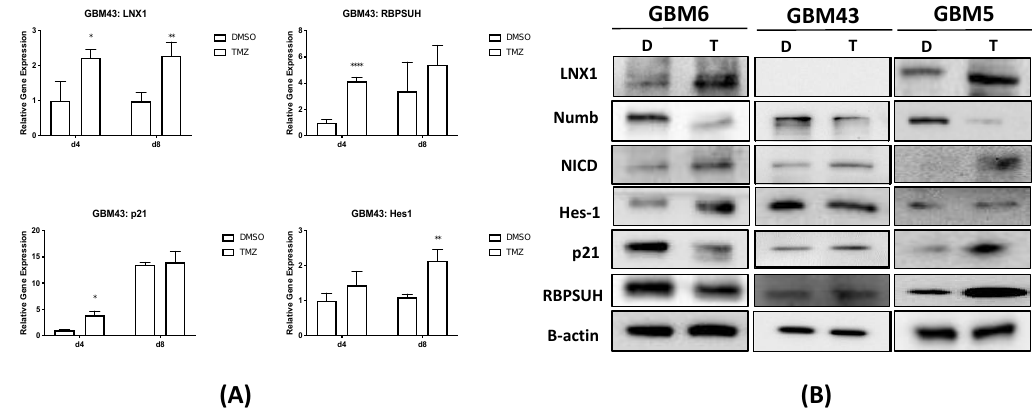
Figure3. TheLNX1-Numb-Notch1axiscontrolsisactivatedafterTMZtherapyinGBM.( A )Examination Figure 3. The LNX1-Numb-Notch1 axis controls is activated after TMZ therapy in GBM. ( A ) of mRNA levels by RT-PCR at 4 and 8 days after therapy with TMZ compared to a DMSO control showed Examination of mRNA levels by RT-PCR at 4 and 8 days after therapy with TMZ compared to a elevations in LNX1, Hes1, p21, and RBPSUH after therapy. ( B ) Western blotting across multiple GBM DMSO control showed elevations in LNX1, Hes1, p21, and RBPSUH after therapy. ( B ) Western patient-derived xenograft (PDX) cell lines and U251 cells showed that LNX1 was upregulated compared blotting across multiple GBM patient-derived xenograft (PDX) cell lines and U251 cells showed that to control after 4 days of TMZ therapy, corresponding with Numb downregulations, and intracellular LNX1 was upregulated compared to control after 4 days of TMZ therapy, corresponding with Numb Notch1 (NICD) upregulations. Following Notch1 upregulation, Notch1 downstream markers p21, downregulations, and intracellular Notch1 (NICD) upregulations. Following Notch1 upregulation, Hes1, and RBPSUH were also elevated. Beta-actin was included as a loading control for all blots Notch1 downstream markers p21, Hes1, and RBPSUH were also elevated. Beta-actin was included as performed. Analysis was performed in Prism 8, using ANOVA to compare row-means to determine a loading control for all blots performed. Analysis was performed in Prism 8, using ANOVA to significance * p < 0.05; ** p < 0.01; **** p < compare row-means to determine significance * p < 0.05; ** p < 0.01; *** p < 0.001.